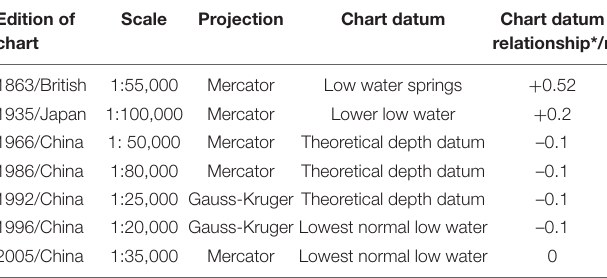
TABLE 1 | Historical chart information of Jiaozhou